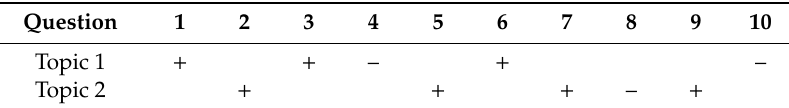
Table 1. Rudimentary two topic quiz